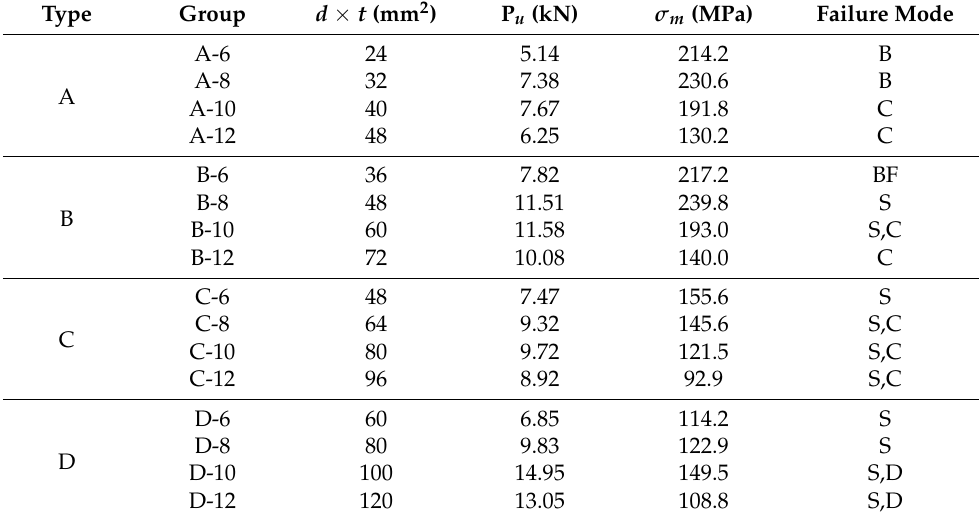
Table 4. Configuration of the test